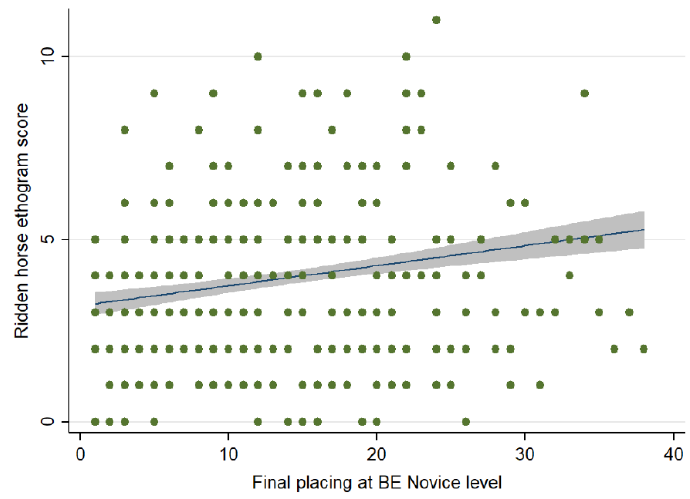
Figure 7. Comparison between the Ridden Horse Pain Ethogram (RHpE) scores and final placings at British Eventing Novice level. The green dots represent individual data points, the blue line is the best linear predicted fit and the grey area represents the corresponding 95% confidence interval.